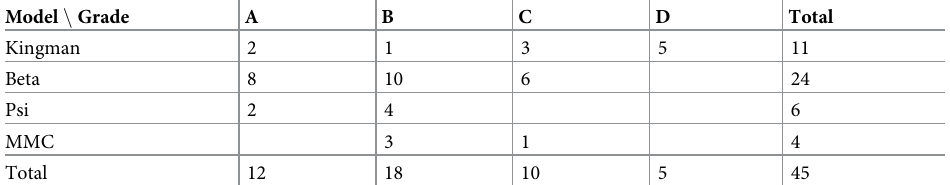
Table 3. Distribution of goodness-of-fit grades of the best-fitting models for the 45 collected SFS. Calculated from Crame´r’s V , A: V 2 [0 : 0.033[, B: V 2 [0.033 : 0.066[, C: V 2 [0.066 : 0.1[ and D: V 2 [0.1 : 1